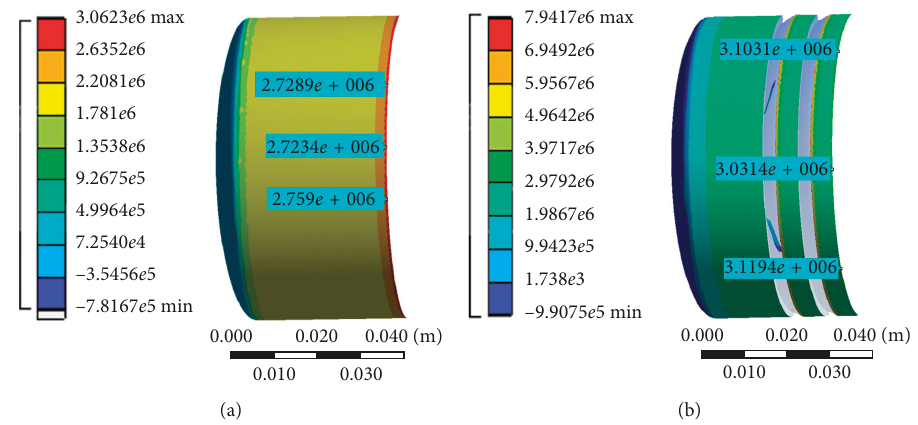
Figure 9: The pressure cloud at piston lips: (a) standard piston; (b) bionic piston.